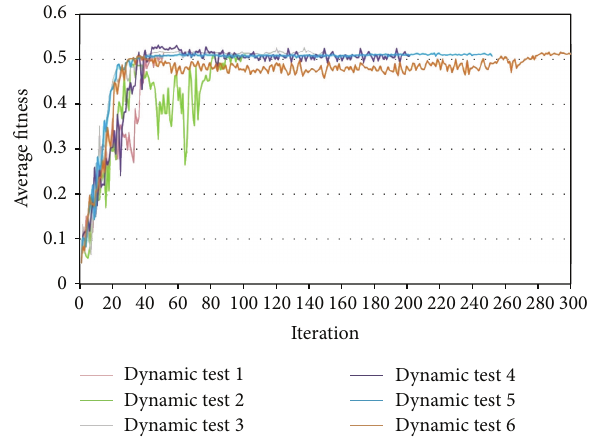
Figure 10: Results of sensitivity tests on dynamic inertia weight.